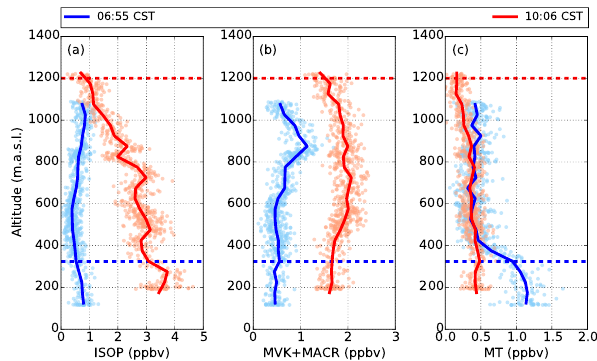
Figure 3. Vertical profiles of VOC species collected using the WASP system. Blue and red indicate data collected on 1 June 2013 (at 06:55CST, over the AABC site) and on 11 June 2013 (at 10:06CST, over the SEARCH site), respectively. The dots repre- sent original data points from the WASP system. The solid lines represent averaged data from the corresponding original data points within each 50m altitude intervals. The dashed lines represent the estimated boundary layer height from ceilometer measurements (see Fig. 4c). The y axis represents GPS altitude in units of me- ters above mean sea level (ma.s.l.). The elevation of the sampling sites is ∼ 67ma . s . l